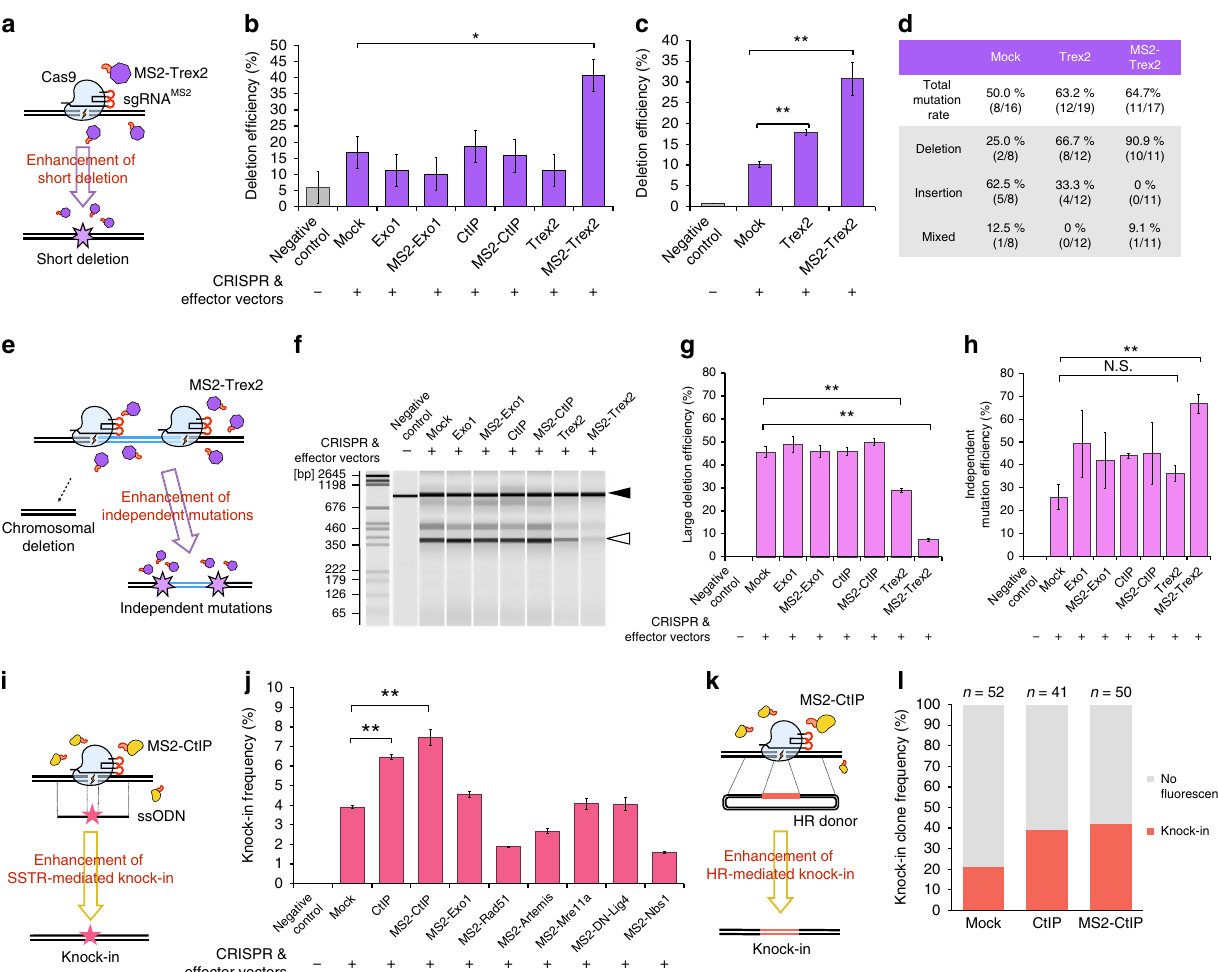
Fig. 4 LoAD system can affect various genome editing outcomes. a Schematic of the enhancement of short deletion with MS2-Trex2 LoADing. b Frequency of short deletion at the LMNB1 locus detected by RFLP analysis. Data are expressed as means ± s.e.m. ( n = 3). * P < 0.05 (Student ’ s t -test). c Frequency of short deletion at the RPL11 locus detected by RFLP analysis. Data are expressed as means ± s.e.m. ( n = 3). ** P < 0.01 (Student ’ s t -test). d Subcloned sequencing analysis revealed that the LoADing of MS2-Trex2 resulted in high-frequency deletions. e Schematic of the enhancement of independent mutations and the suppression of chromosomal deletion with MS2-Trex2 LoADing. f Pseudo-gel image of the out – out PCR products at APC locus 1, illustrated in Supplementary Figure 19a. Black and white arrowheads indicate the expected positions of the wild type and chromosomally deleted PCR products, respectively. g Percentages of chromosomally deleted alleles among all the out – out PCR products at APC locus 1. Data are expressed as means ± s.e.m. ( n = 3). ** P < 0.01 (Student ’ s t -test). N.S., not signi fi cant. h Percentages of independently mutated alleles among the full-length PCR products indicated by the black arrowhead in Fig. 4f. The mutations were detected by genomic cleavage detection assay 36 . Pseudo-gel image of this assay is shown in Supplementary Figure 19b. Data are expressed as means ± s.e.m. ( n = 3). ** P < 0.01 (Student ’ s t -test). i Schematic of the enhancement of ssODN knock- in mediated by single-strand template repair (SSTR) with MS2-CtIP LoADing. j Ef fi ciencies of ssODN knock-in detected by RFLP analysis, related to Supplementary Figure 20. Data are expressed as means ± s.e.m. ( n = 3). ** P < 0.01 (Student ’ s t -test). k Schematic of the enhancement of plasmid knock-in mediated by homologous recombination (HR) with MS2-CtIP LoADing. l Ef fi ciencies of HR-mediated knock-in, related to Supplementary Figure 21. The knock-in rate was calculated as the percentages of knock-in clones among the total number of